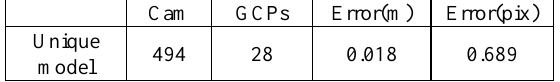
Table 6. Cameras, GCPs and residual error of GCPs estimated by PhotoScan for the entire